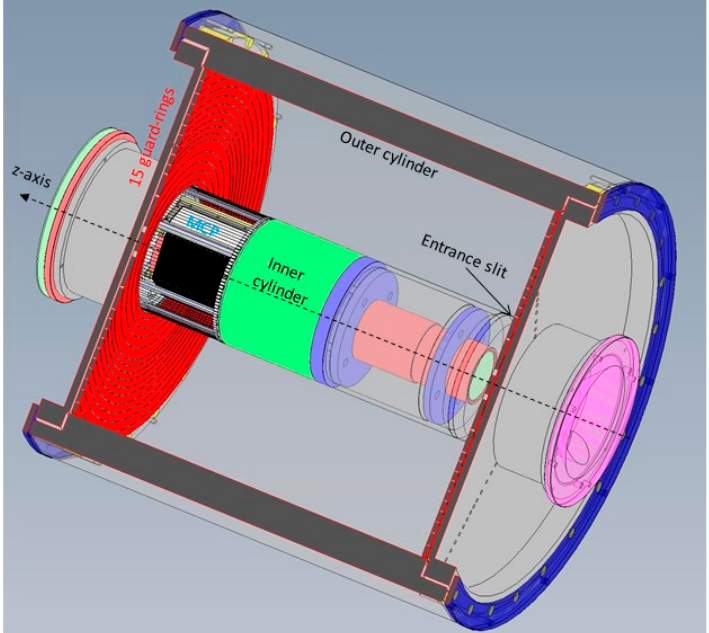
Figure 2. ( a , b ) The drawing of the detector. ( c ) hexagonal holder for the 0.5 mm threaded alumina